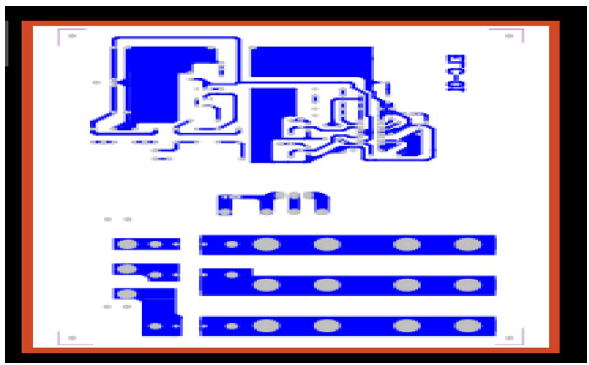
Fig.5 PCB layout of the EGLC Controller